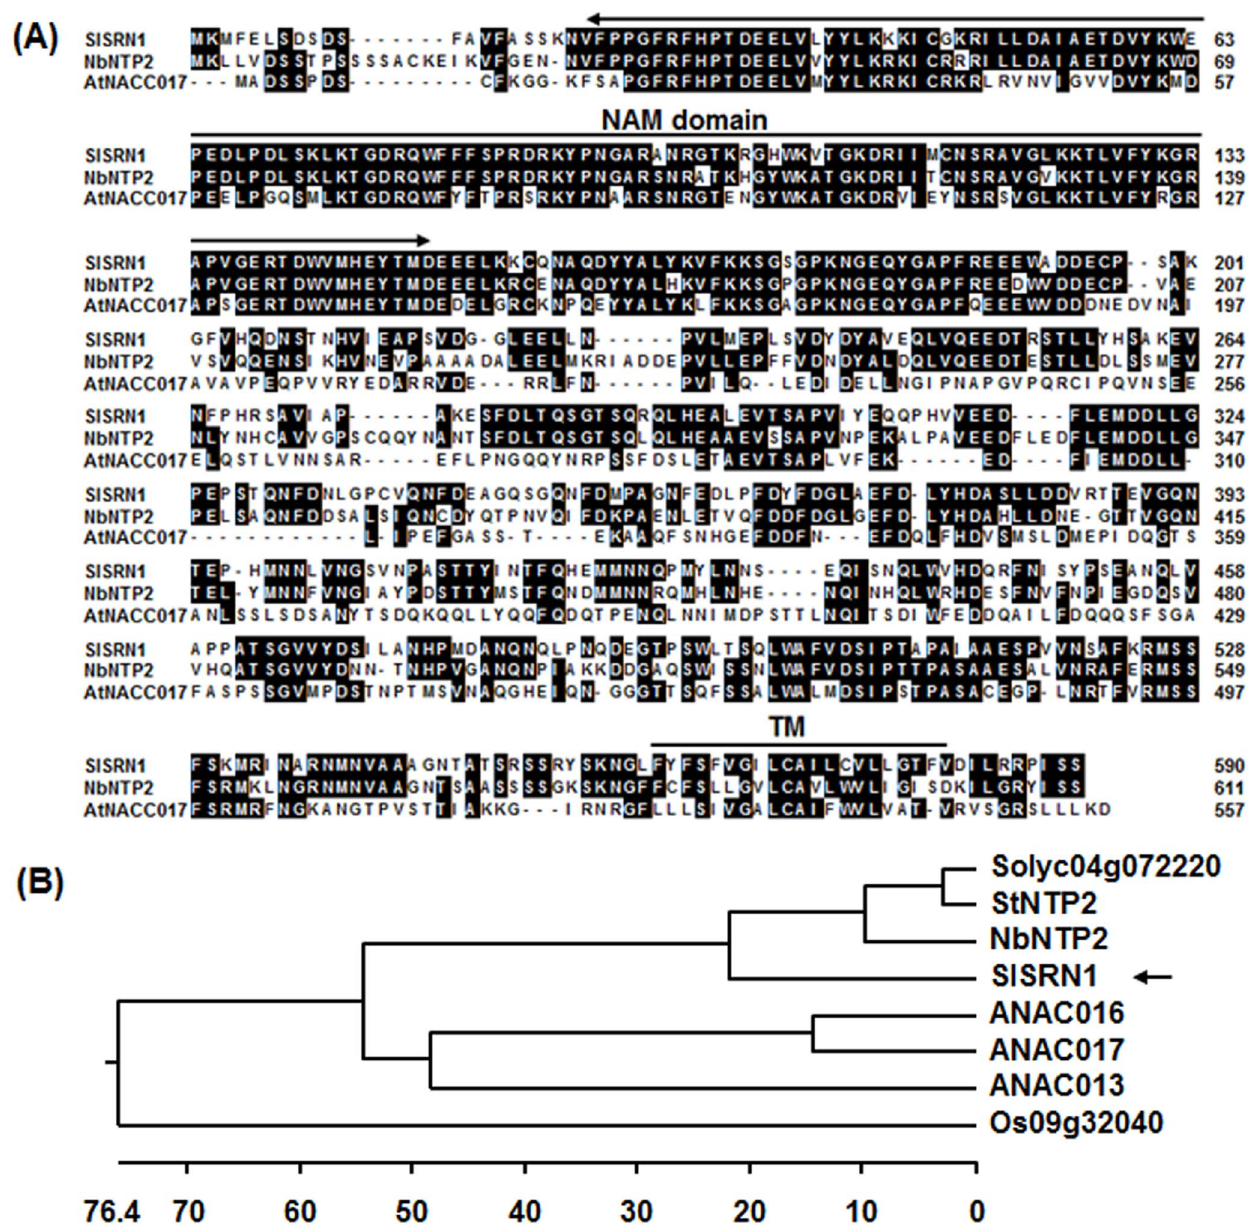
Figure 1. Sequence alignment and phylogenetic tree analysis of SlSRN1 with other plant NAC proteins. A. Sequence alignment of SlSRN1 with NbNTP2 and AtNAC017. The numbers on the left indicate amino acid positions of the proteins used. Shared amino acid residues are shown in black background. Conserved NAC domain and putative transmembrane motif are indicated. B. Phylogenetic tree analysis of SlSRN1 with other plant NAC proteins. Phylogenetic tree was constructed by neighbour-joining method using MEGA program version 6.05. SlSRN1 in the tree is indicated by an arrow. Plant NAC proteins used and their GenBank accessions are as follows: Arabidopsis AtNAC017 (AAK32826), AtNAC016 (AAD39614) and AtNAC013 (AEE31534), Nicotiana benthamiana NbNTP2 (AGY49287), potato StNTP2 (AGY49285) a tomato predicted NAC (Solyc04g072220) and rice Os09g32040 (BAF25461).